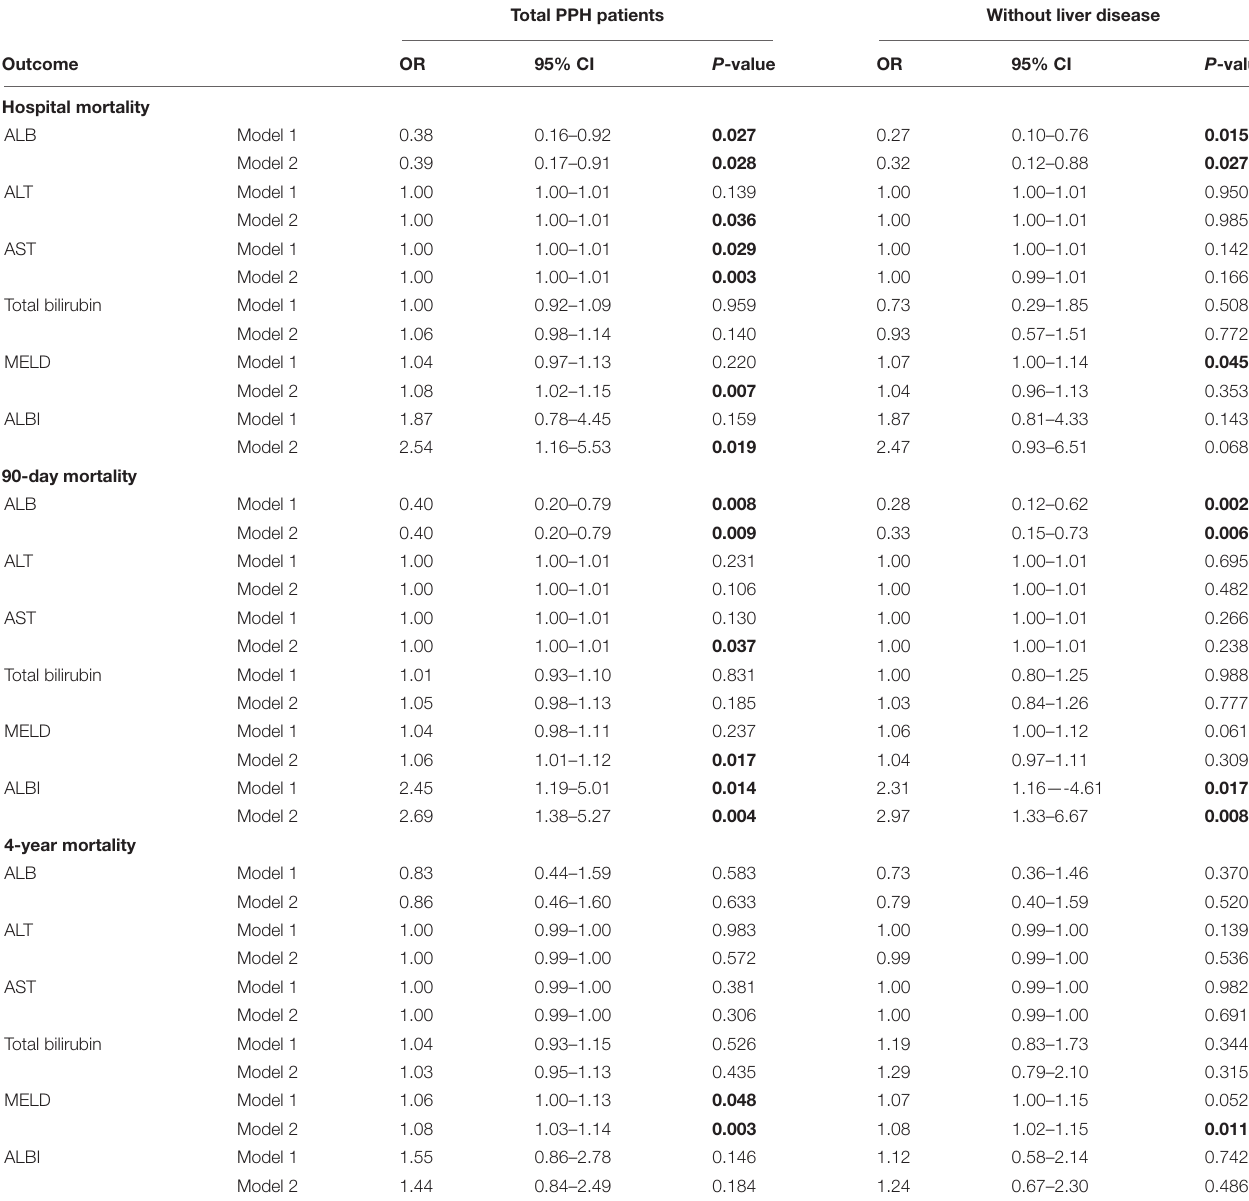
TABLE 7 | Association between ALB, ALT, AST, and total bilirubin with prognosis of patients with PPH. Total PPH patients Without liver